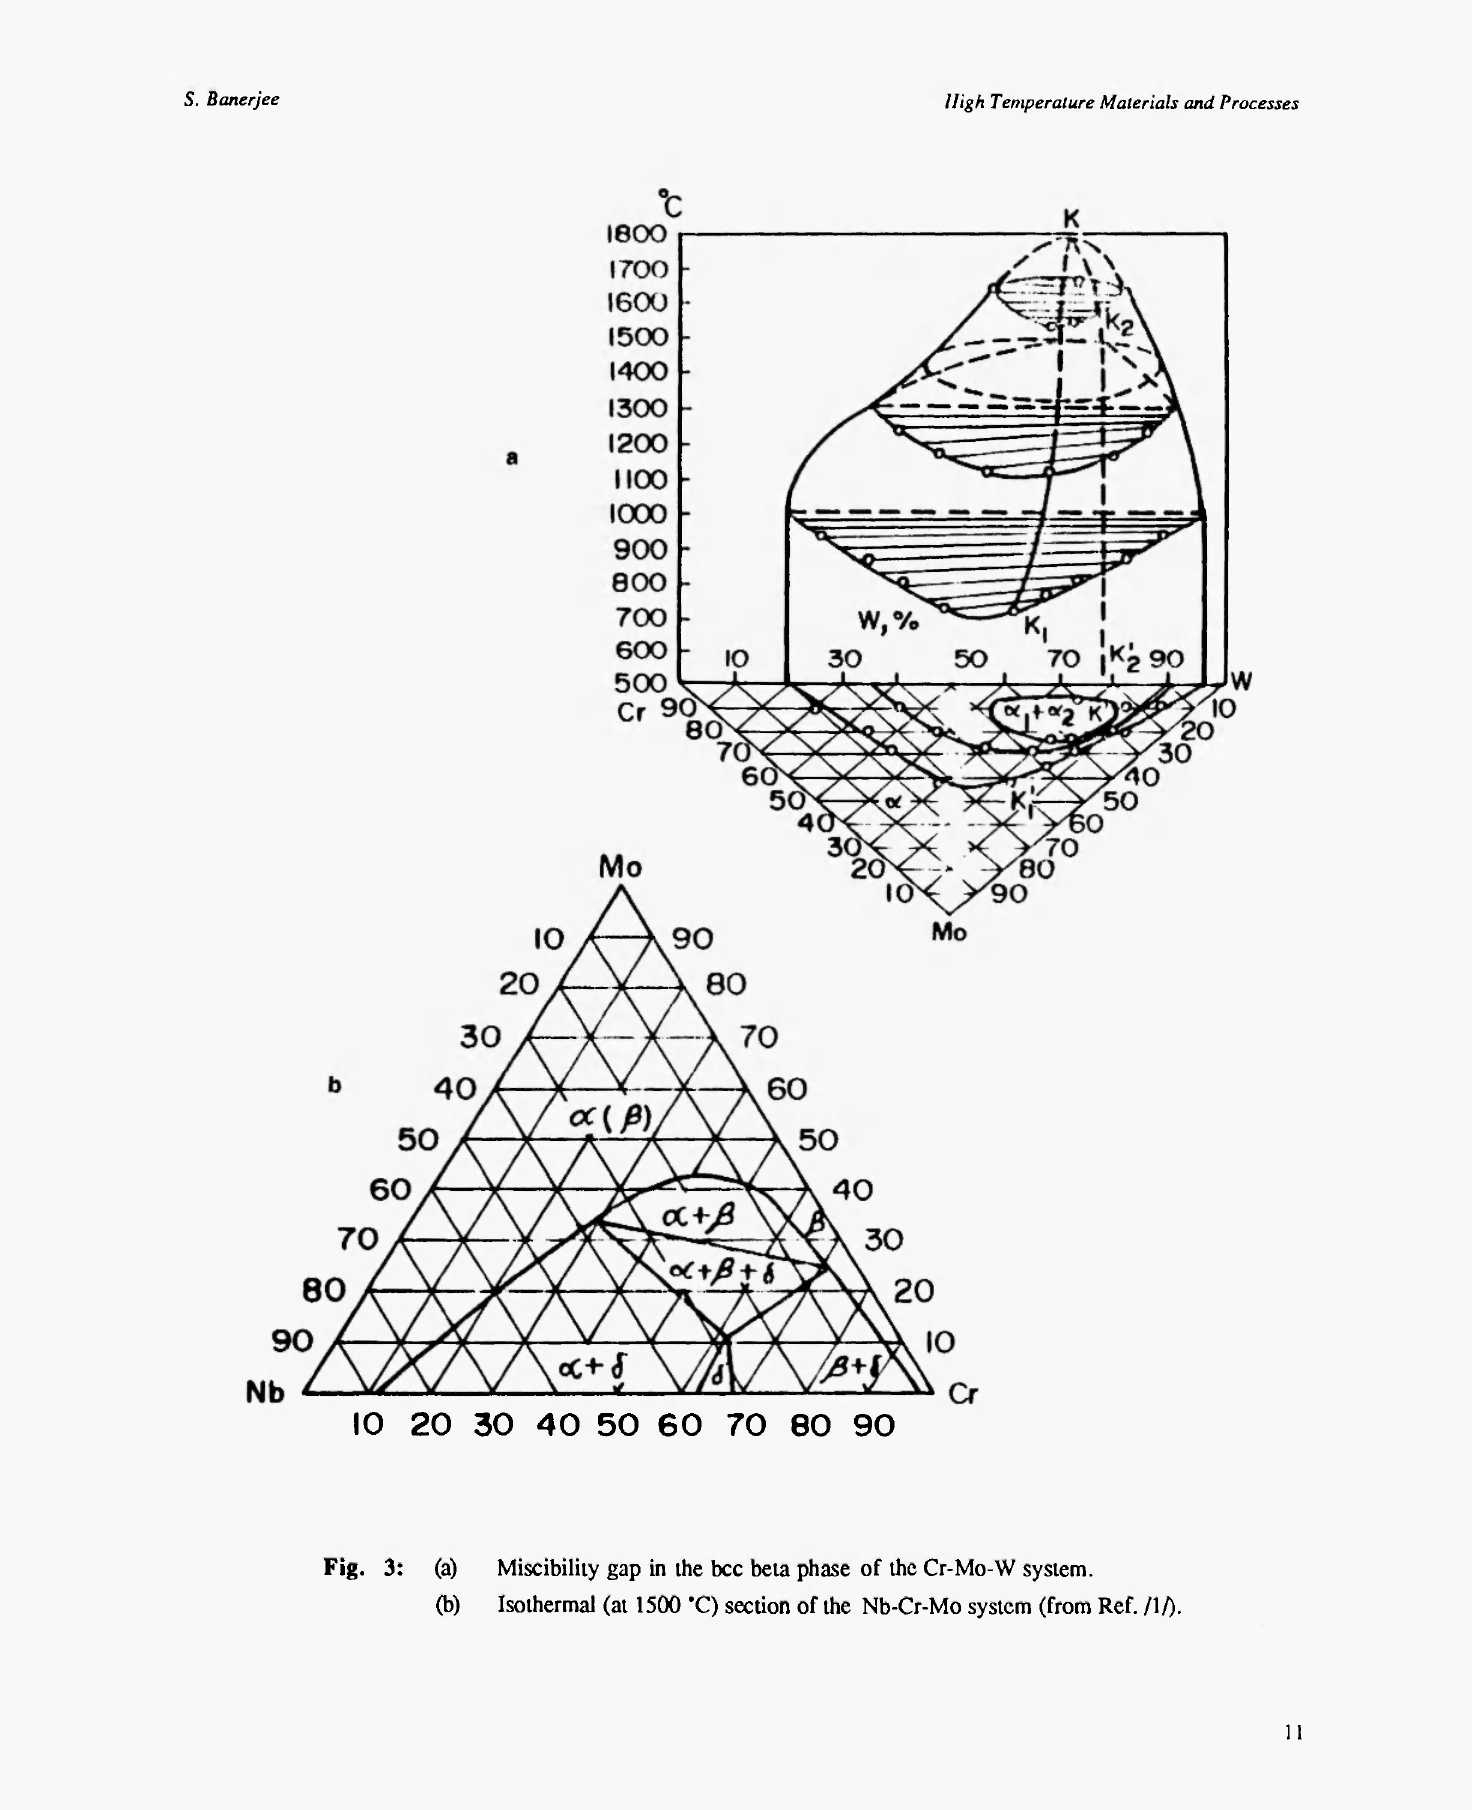
Fig. 3: (a) Miscibility gap in the bcc beta phase of the Cr-Mo-W system. (b) Isothermal (at 1500 'C) section of the Nb-Cr-Mo system (from Ref.